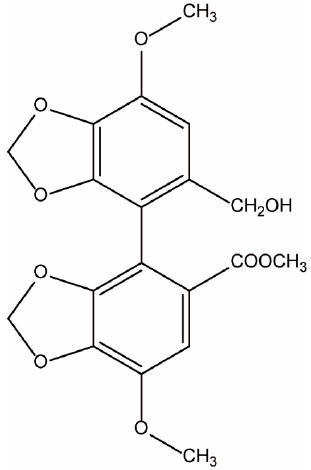
Figure 1. Chemical structure of bicyclol.